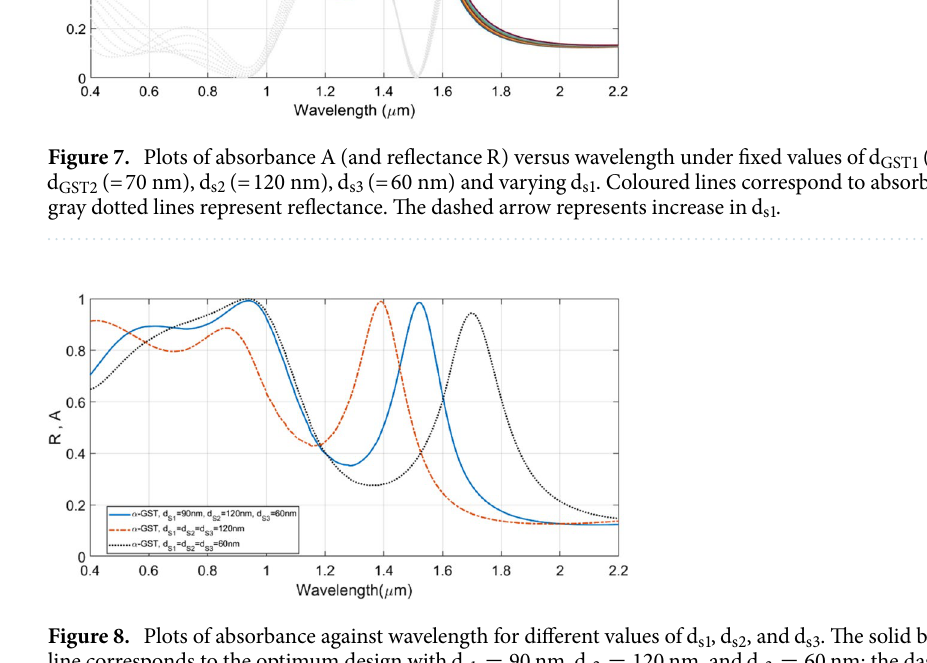
60 nm; the dashed =